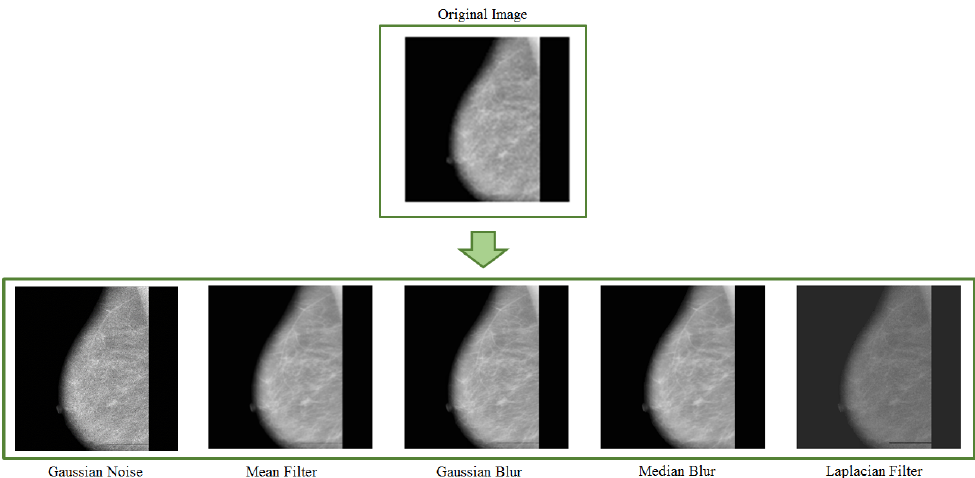
Figure 7. Example of data augmentation based on various filters and